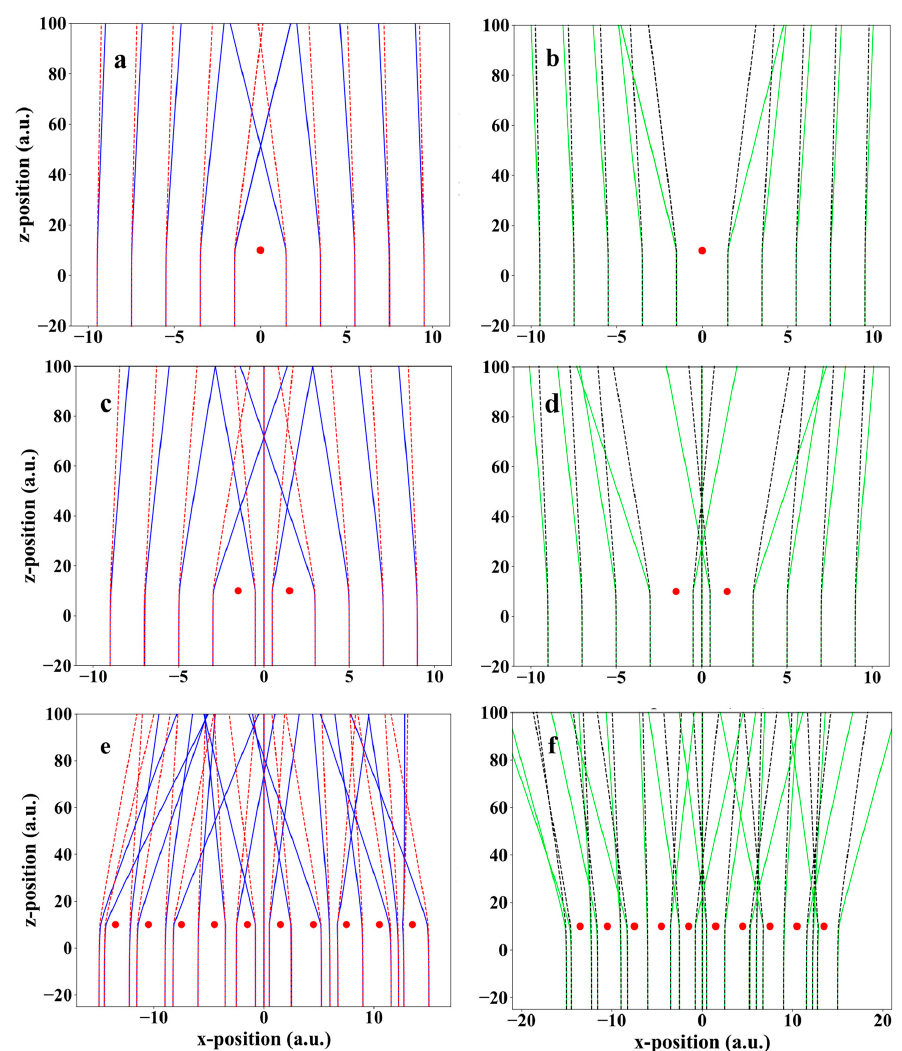
Figure 2. Trajectories of projectiles in three configurations of the target system, ( a ) electrons with one proton, ( b ) positrons with one proton, ( c ) electrons with two protons, ( d ) positrons with two protons, ( e ) electrons with ten protons, ( f ) positrons with ten protons. Blue solid lines: electrons with initial energy of 500 eV, red dashed lines: electrons with initial energy of 1000 eV, green solid lines: positrons with initial energy of 500 eV, black dashed lines: positrons with initial energy of 1000 eV, red circle shows positions of the protons.